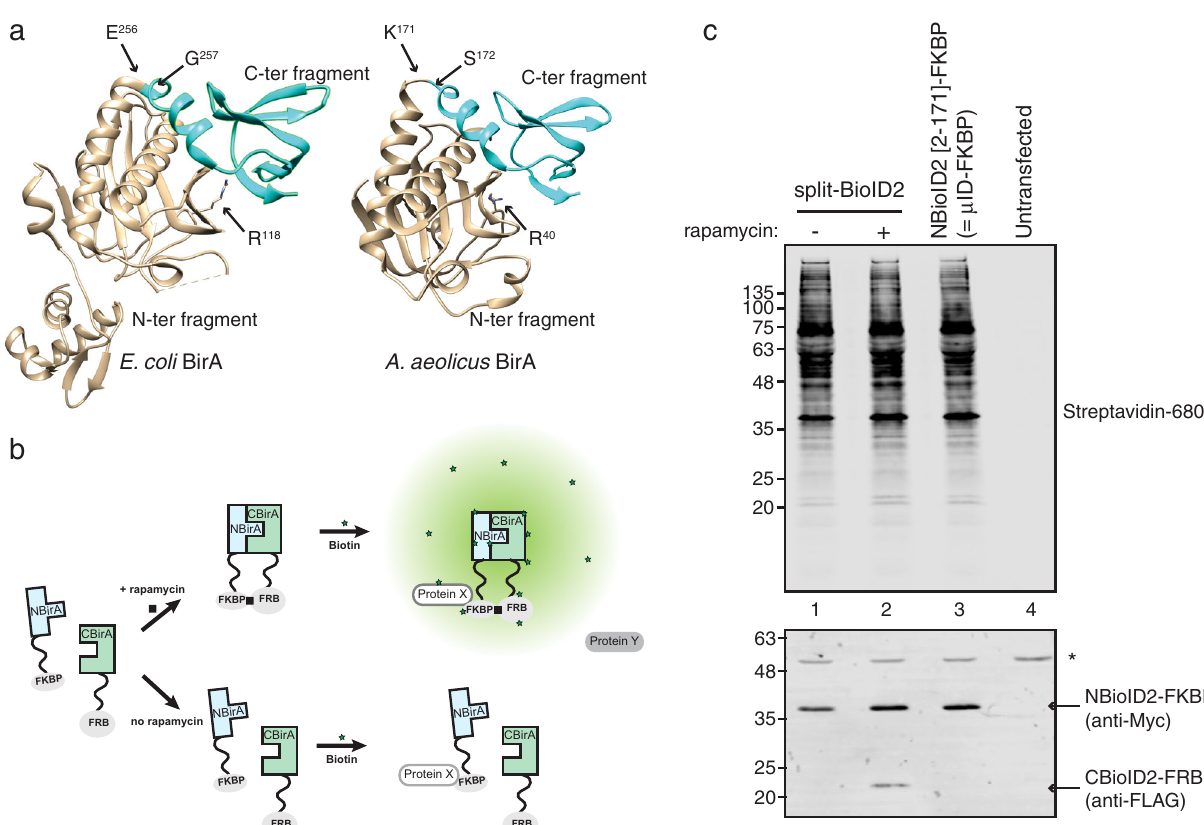
Fig. 1 A truncation fragment of BioID2 with promiscuous biotinylation activity. a E. coli ’ s and A. aeolicus ’ BirA crystal structures (Protein Data Bank 1HXD and 3EFS) showing the splitting site of split-BioID (E 256 /G 257 ) and its corresponding position in BioID2 (K 171 /S 172 ) as well as the mutated arginine (R 118 or R 40 ). b Principle of the rapamycin-induced dimerization set-up to test split-BioID fragments: FKBP is fused to the N-terminal fragment and FRB to the C-terminal fragment. PDB is tested in the presence or absence of rapamycin. c Blots of lysates of HeLa cells transiently transfected with the indicated constructs and cultivated overnight in biotin-containing medium in the presence or absence of rapamycin. Biotinylation was analyzed using IRDye680- labeled streptavidin and expression levels of the fusion proteins with antibodies against FLAG and Myc tag as indicated. The asterisk (*) indicates a non- speci fi c cross-reactivity that was used as a loading